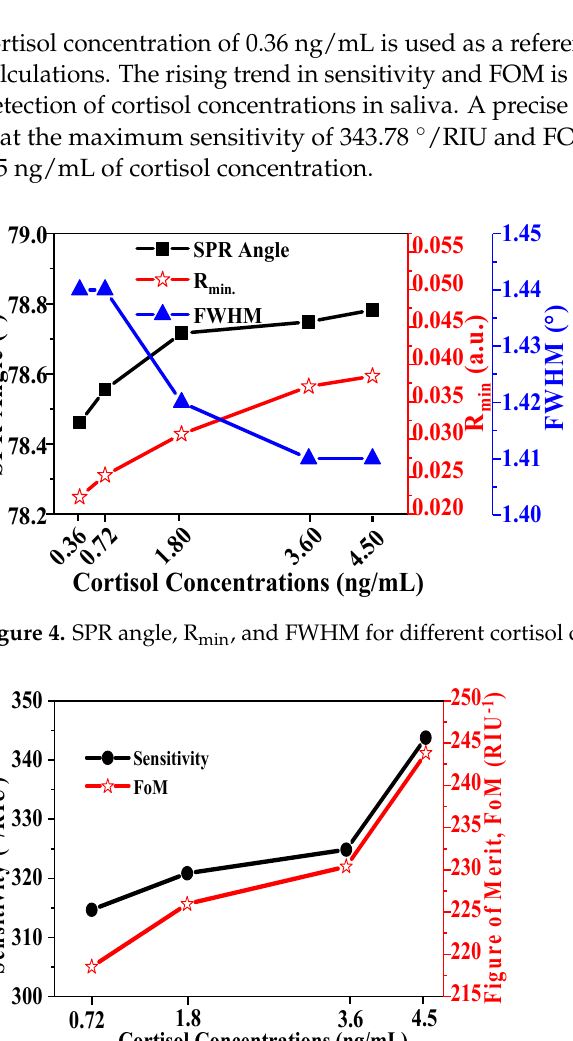
Figure 5. Sensitivity and FOM for different cortisol concentrations (0.72 to 4.5 ng/mL).